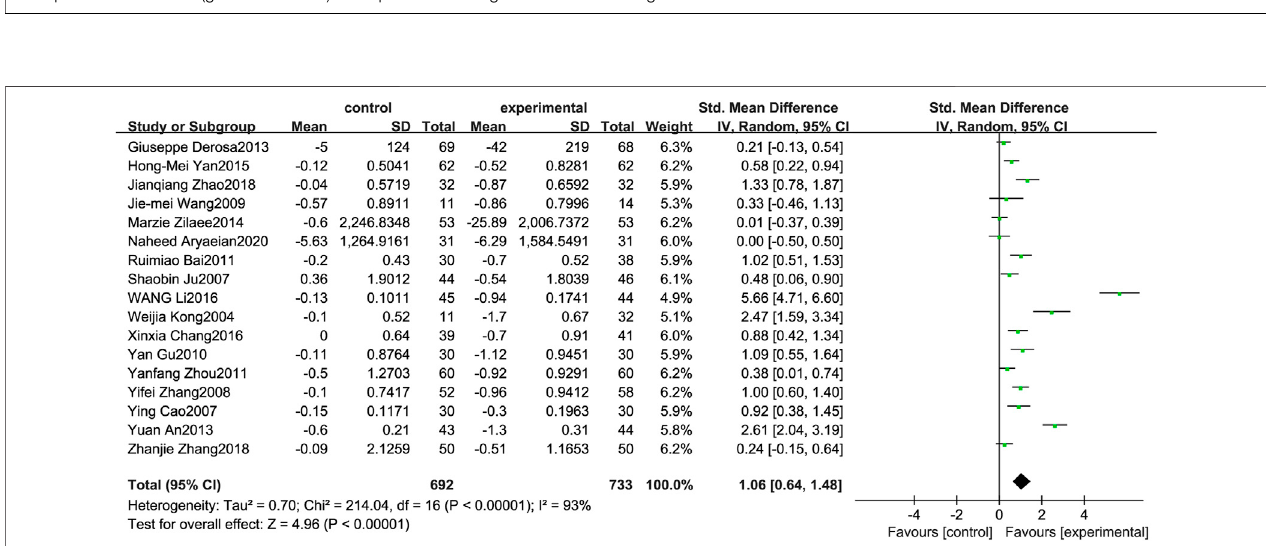
FIGURE4| Meta-analysisandmigrationanalysisoftheeffectofberberineontotalcholesterol.Forestplotillustratesthedifferencesinchangesintotalcholesterolin adults with metabolic disease who did or did not receive berberine in 15 trials ( n (cid:1) 1,297). The mean difference (blue squares), 95% CI (horizontal lines through blue squares), and pooled-effect sizes (green diamonds) were presented using random-effect Hedges models.